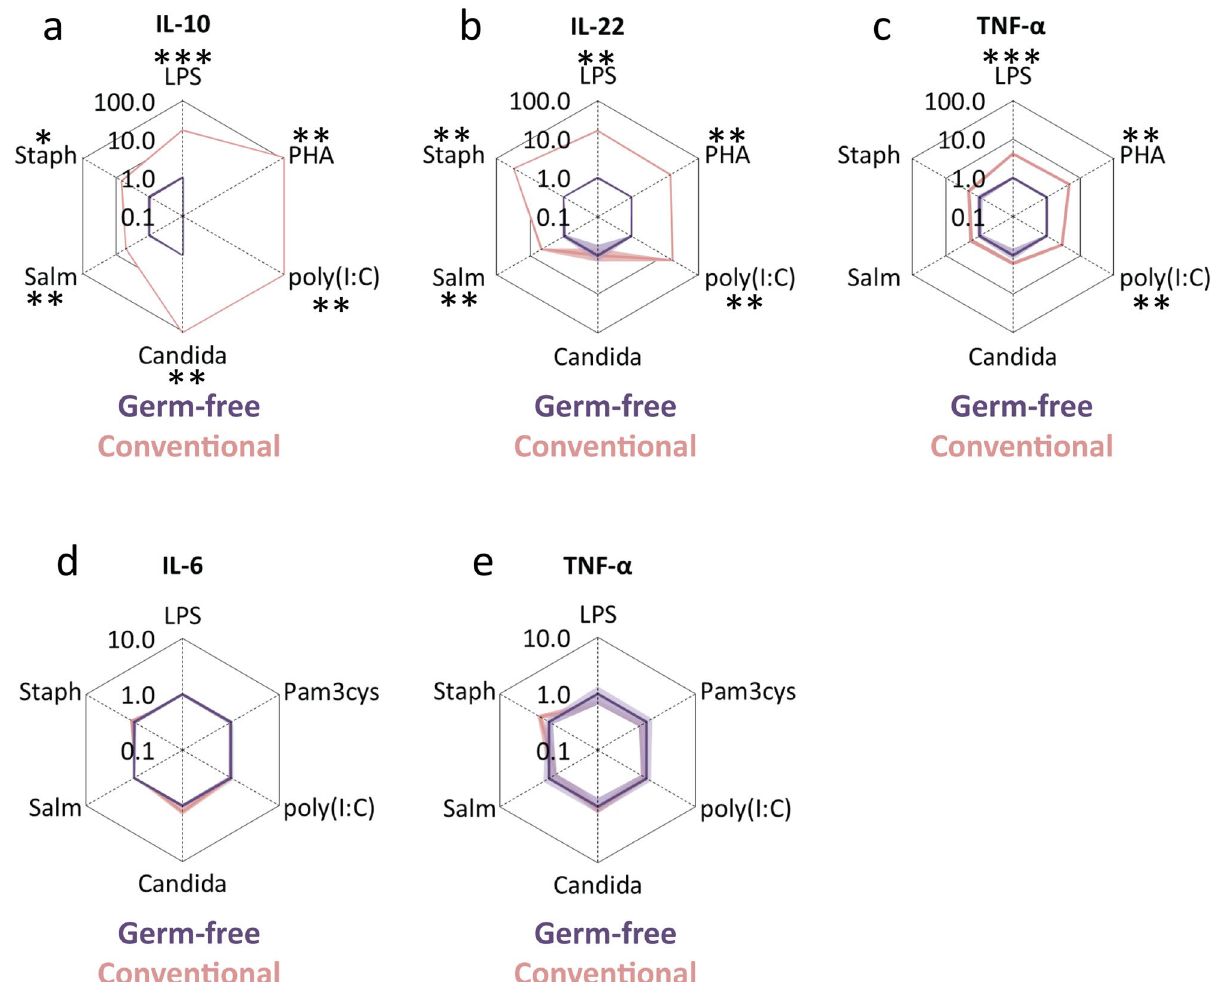
Figure 5. Cytokine secretion of stimulated splenocytes and peritoneal macrophages from germfree versus conventionally housed mice. Spiderplots show ( a ) IL-10, ( b ) IL-22 and ( c ) TNF-α release from splenocytes of germfree mice (inner purple lines) upon stimulation with different stimuli compared to splenocytes of conventional mice (outer pink lines). Spiderplots show ( d ) IL-6 and ( e ) TNF-α release of peritoneal macrophages of germfree mice (inner purple lines) upon stimulation, compared to conventional mice (outer pink lines). Cytokine concentrations in response to the stimuli are normalized to the cytokine concentrations of splenocytes of germfree mice (inner grey lines), averaged per group and plotted on a log scale. See legend to Fig. 1 for more information. Values are means ± SEM; Groups were compared using Mann–Whitney U test; n = 4–9; *p < 0.05; **p < 0.01; ***p <